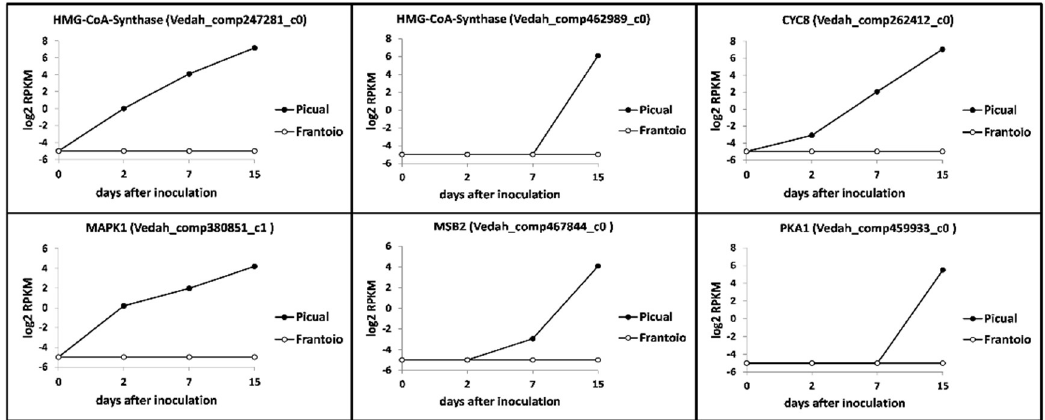
Figure 7. Verticillium dahliae unigenes related to pathogenicity, virulence and microsclerotia development and differentially expressed in ‘Picual’ and ‘Frantoio’ roots during infection. Samples were analyzed by RNAseq (see the Results section for details). RPKM, Reads Per Kilobase Million.